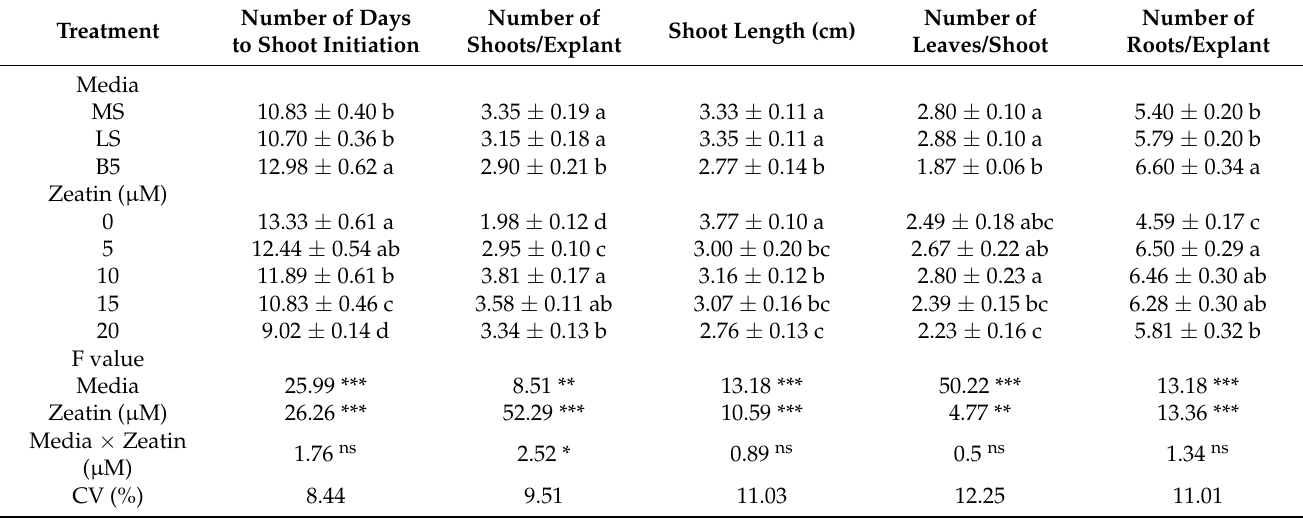
Table 3. Main effects of different basal media and zeatin concentrations on number of days to shoot initiation, number of shoots per explant, shoot length, number of leaves per shoot, and number of roots per explant of Bentong ginger after six weeks of